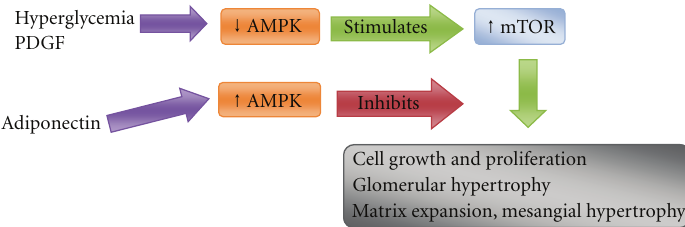
Figure 1: Hyperglycemia and PDGF stimulate mTOR, which in turn contribute to the nuclear translation of mRNAs necessary for cell growth and proliferation, clinically evident as hematuria, proteinuria, and glomerular filtration rate alterations. this dose is below that used to produce clinically